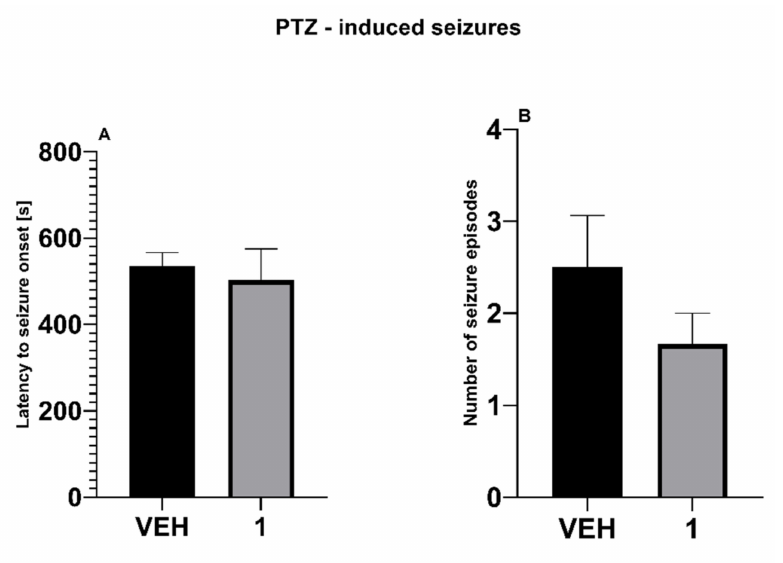
Figure 5. Influence of the test compound 1 at the dose of 100 mg/kg on latency to first clonus ( A ) and the number of seizure episodes ( B ) in PTZ-induced seizure model. Statistical analysis: Student’s t -test test. Significance vs. vehicle-treated mice: p > 0.05.